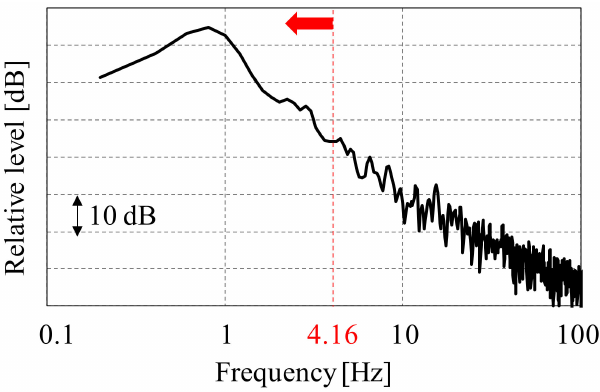
Figure 8. Frequency components of the fluctuation in the vibration time-series data for the lifter under normal condition.